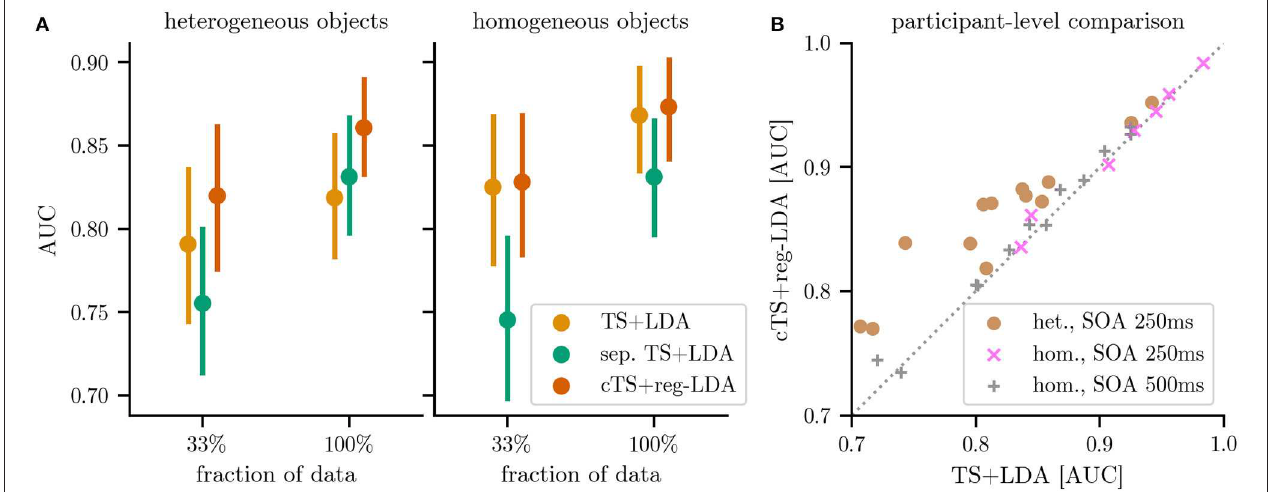
FIGURE 6 | Performance of the different classification pipelines for classifying individual responses: Riemannian tangent space classification ignoring subclass information ( TS+LDA ), separate tangent space classifiers for each subclass ( sep. TS+LDA ) and the proposed separate subclass-regularized classifiers in centered tangent spaces ( cTS+reg-LDA ). For the latter two approaches, each object corresponds to a separate subclass. (A) shows the results for heterogeneous objects (combining the 13 participants of datasets HET1 and HET2 ) and for homogeneous objects (combining the 19 participants of datasets HOM 1, HOM2 , and HOM3 ). (B) plot compares the performance of cTS+reg-LDA and TS+LDA on the level of individual participants (colors indicate differing object types and SOA). Markers above the diagonal indicate that the proposed cTS+reg-LDA outperforms TS+LDA . Results are reported using the area under the receiver operating characteristic (AUC, higher is better) and error bars correspond to bootstrapped 95% confidence intervals. Detailed results can be found in Table 2